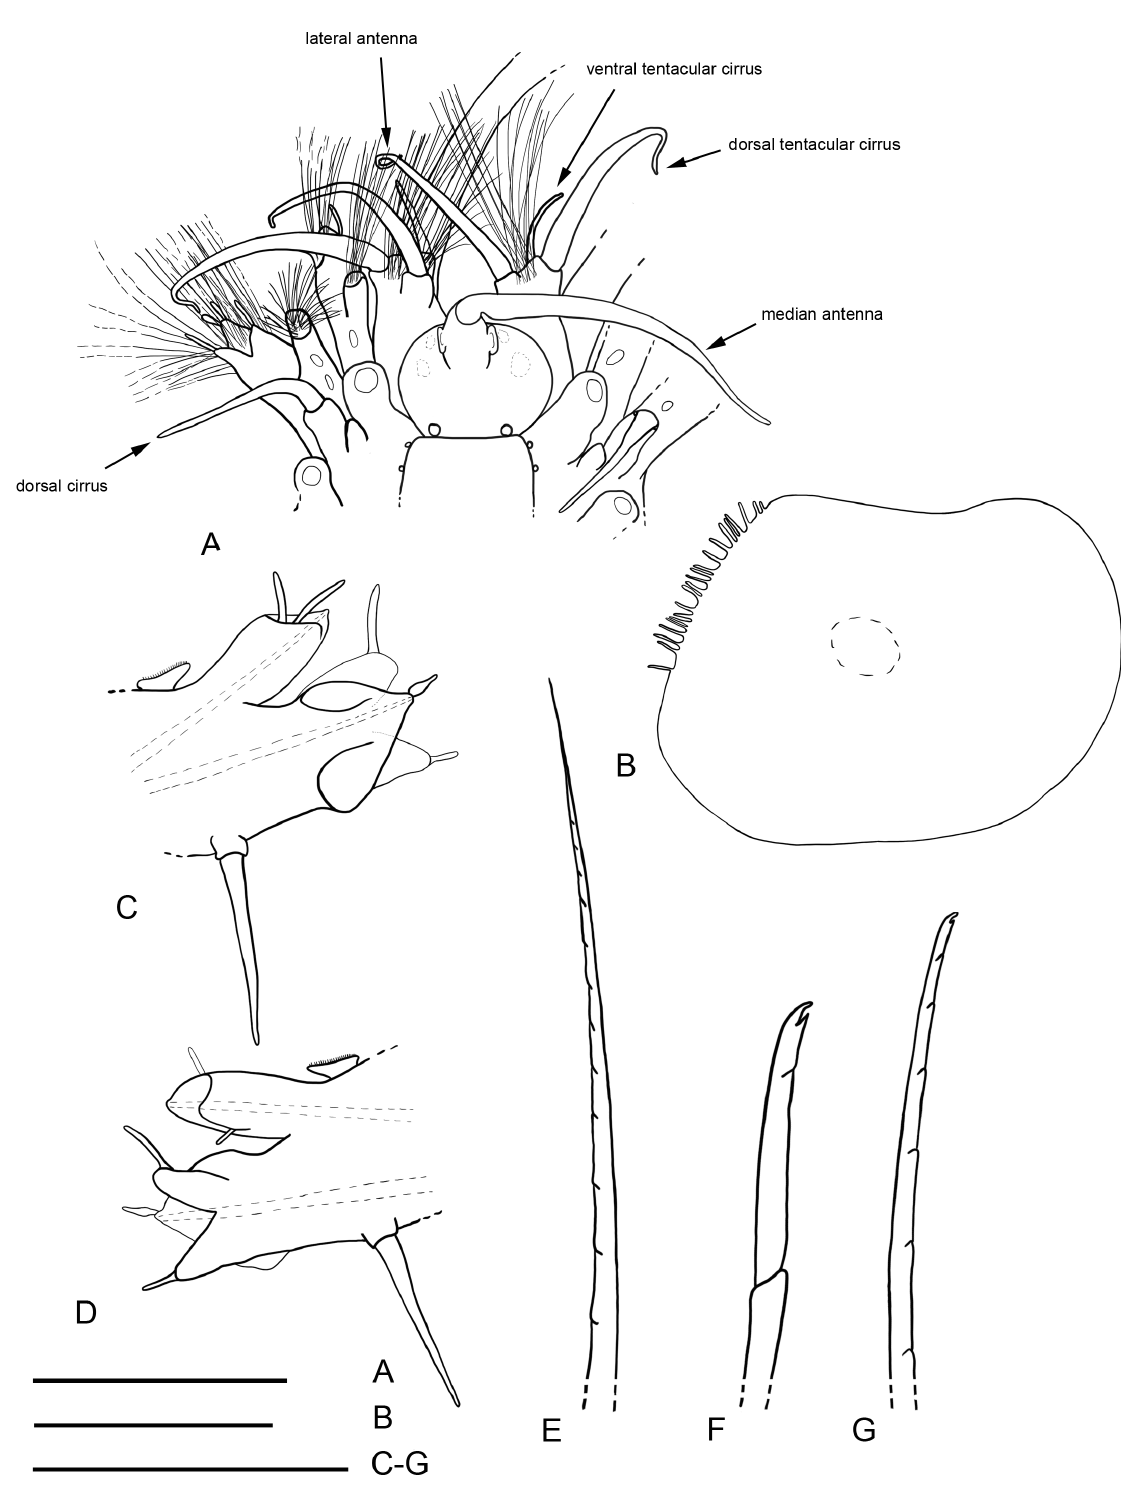
Fig. 8. Eusthenelais hibernica McIntosh, 1876. TUM 65571. A . Anterior end, left palp not figured, bent downwards. B . Left elytron of segment 17. C . Left parapodium of segment 19, anterior view. D . Same, posterior view. E–G . Neurochaetae of same, all distal part. E . Upper compound spiniger. F . Middle stout compound falciger. G . Lower slender compound falciger. Scale bars: A = 2 mm; B–D = 1 mm; E–G = 100 µm.